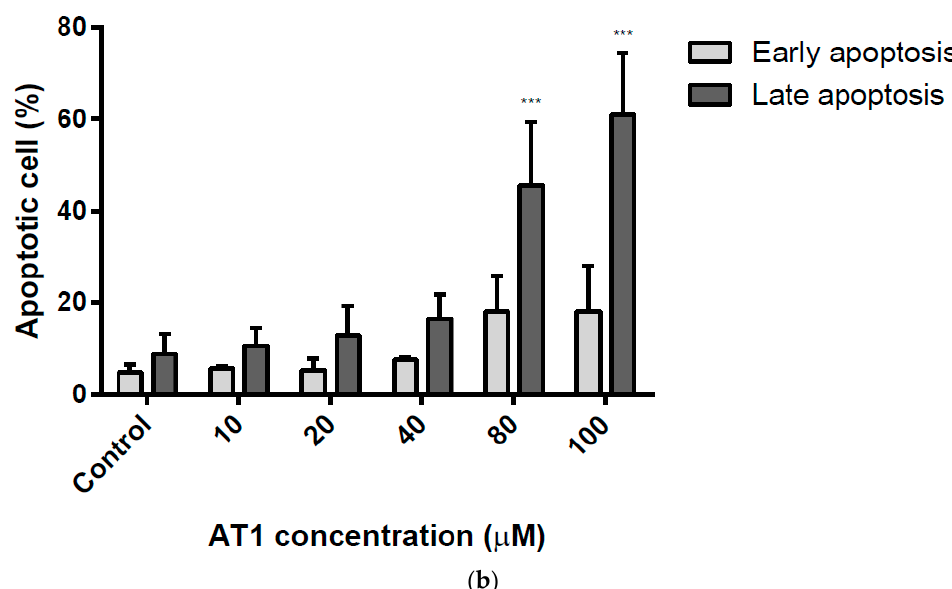
Figure 5. The effects of various concentrations of AT-I on apoptosis in HT-29 cells were assessed by Annexin V-FITC/PI double stain using flow cytometry. Cells were treated with AT-I for 48 h and analyzed using flow cytometry. The control group was not treated with AT-I. ( a ) A dot plot to represent number of apoptotic events after treatment with various AT-I concentrations, as well as positive and negative controls. This is a representative of three independent experiments. The top left quadrant represents dead cells (PI positive; Annexin V-FITC negative); the bottom left quadrant represents living cells (PI negative; Annexin V-FITC negative); the top right quadrant represents cells in late apoptosis phase (PI positive; Annexin V-FITC positive); the bottom right quadrant represents cells in early apoptosis phase (PI negative; Annexin V-FITC positive). ( b ) A bar chart to present the percentage of apoptotic cells after treatment with various AT-I concentrations. Data are shown as mean ± SD, n = 3. Significant differences are indicated by *** p < 0.001 as compared with the control group.